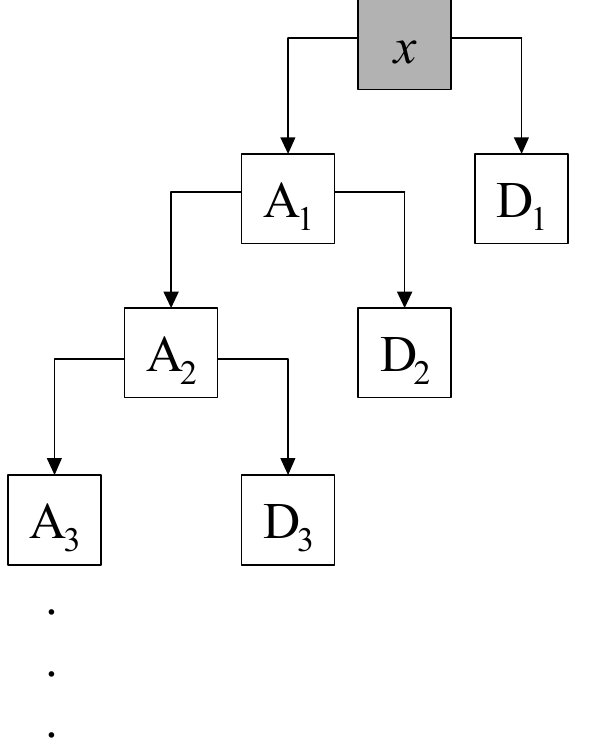
Fig. 1. Schematic diagram of a wavelet multi-resolution analysis. (Modified from Misiti et al.,